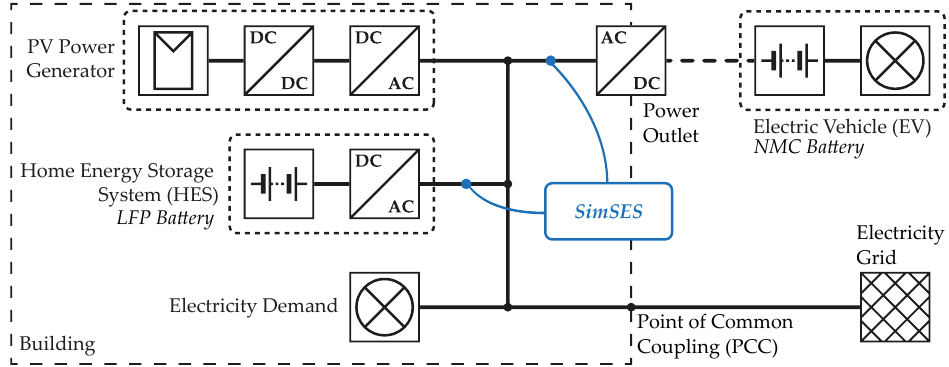
Figure 3. Residential power flow (RPF) model, consisting of the AC-coupled home energy storage system (HES), a photovoltaic (PV) power generator, electricity demand, the power outlet with the connected electric vehicle (EV), and the superordinate electricity grid. The simulation tool SimSES is used to validate the technical characteristics of the considered battery energy storage system